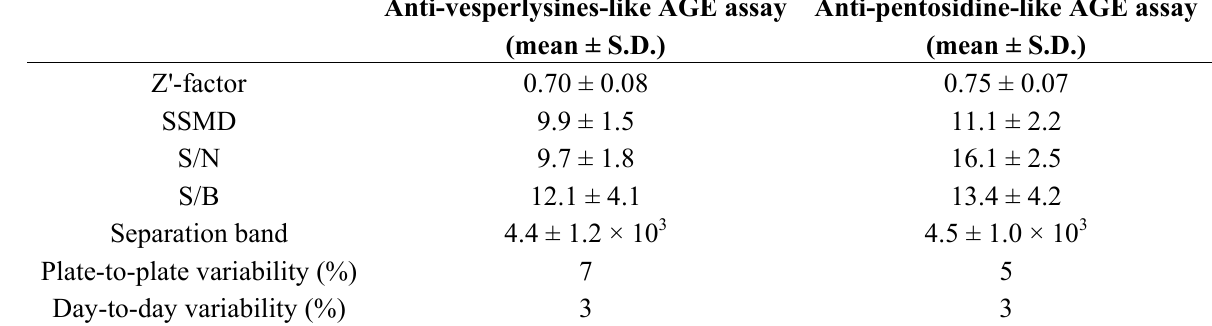
Table 1. Statistical analysis and comparison of both anti-vesperlysines-like and anti-pentosidine-like AGE assays. BSA (10 mg/mL) was incubated with D -ribose (0.5 M) in phosphate buffer to obtain positive controls. BSA alone was used as blank control. Solutions were incubated in 96-well microtiter plates at 37 °C for 24 h before vesperlysines- like ( λ 370 nm, λ 440 nm) and pentosidine-like ( λ 335 nm, λ 385 nm) AGE exc em exc em fluorescence